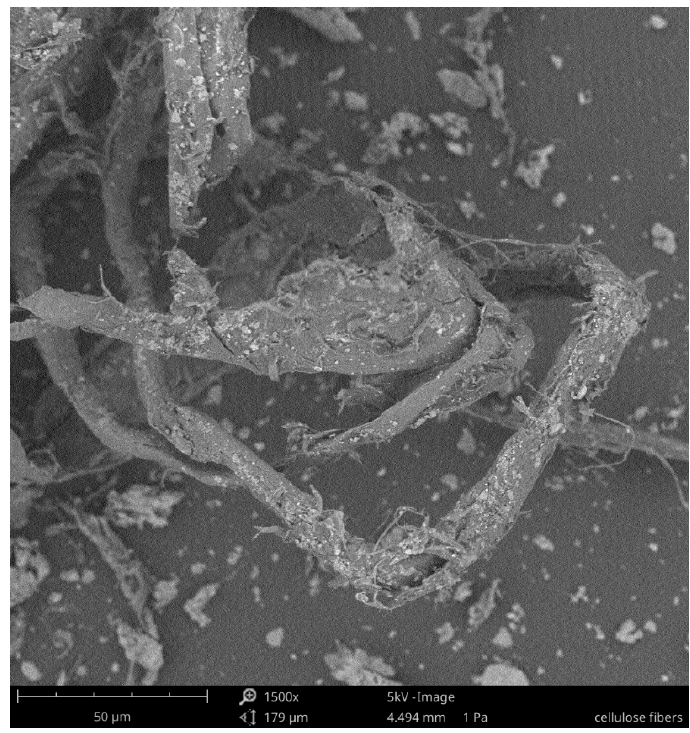
Figure 1. Particle size distribution of SAP.